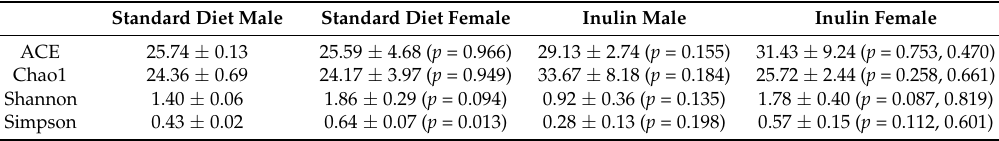
Table 3. Alpha index analysis of InR p5545 /TM3 D. melanogaster on an inulin-supplemented diet or a standard diet.